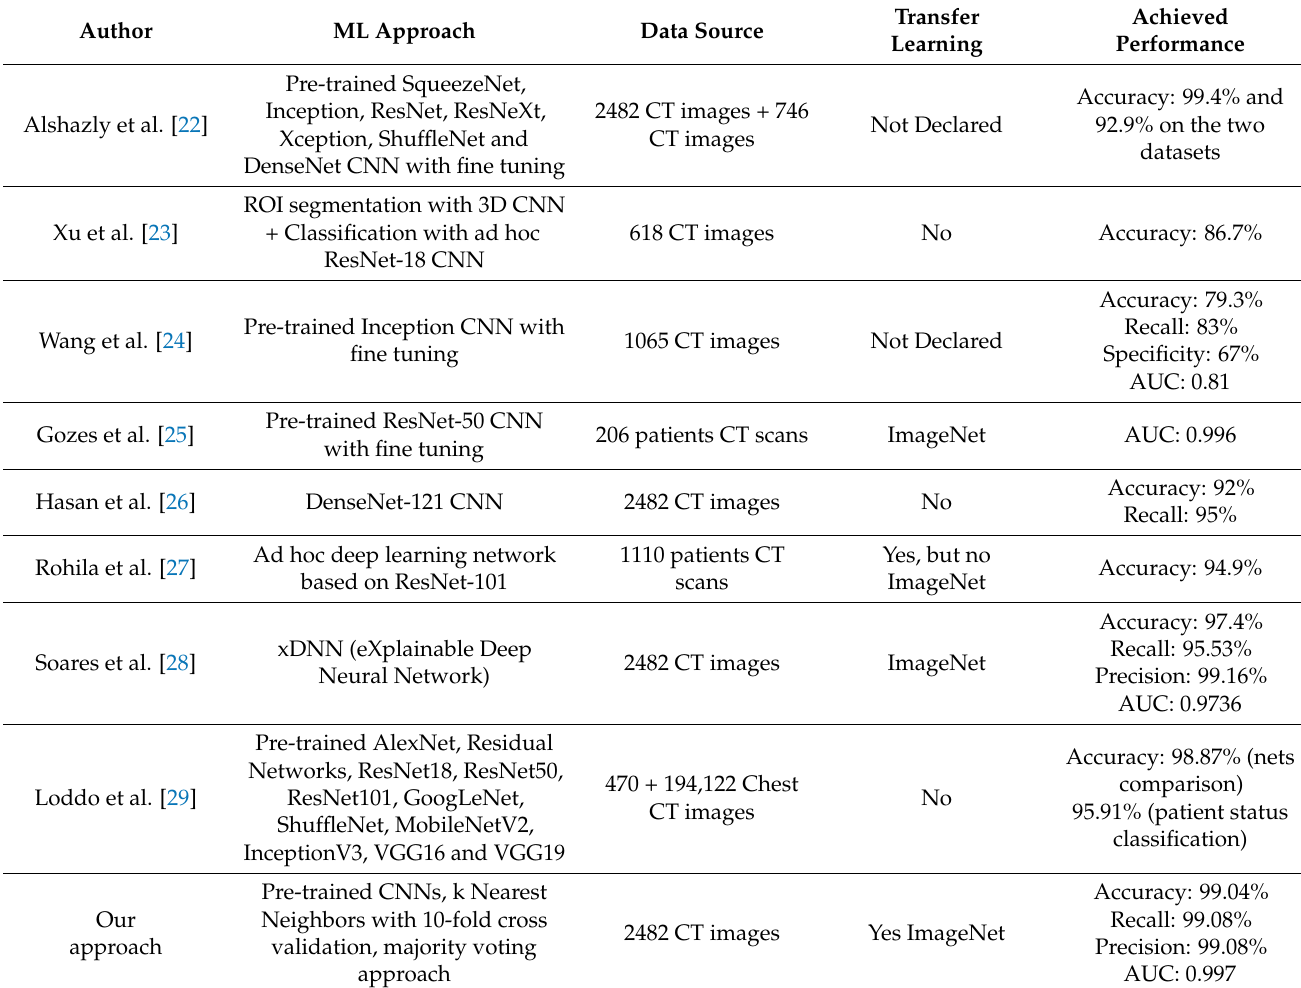
Table 6. Related works for COVID-19 infection